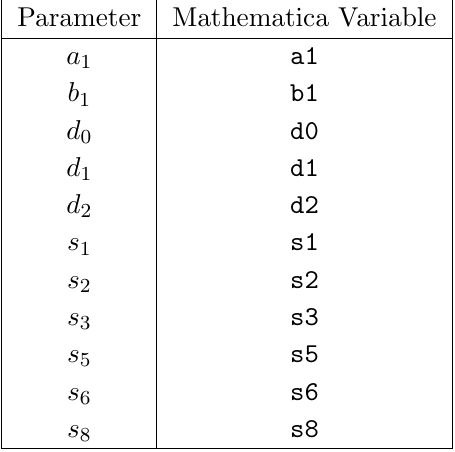
Table 10 . Mathematica variables corresponding to the parameters in the q = 4 model. as ancillary (cid:12)les in the arXiv submission and can be obtained by downloading the gzipped source of the submission. Each (cid:12)le contains the f and g of the Weierstrass model (assigned to the variables f and g ) and the ^ x , ^ y , and ^ z components of the generating section (assigned to the variables x , y , and z ). Because some of the parameters have typographical features, such as subscripts or macrons, that are not easily used in Mathematica, the